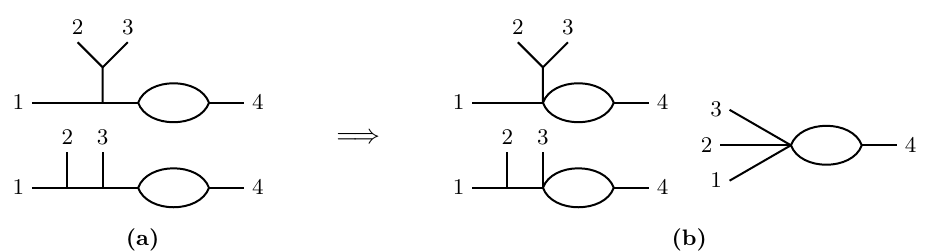
Figure 4. The BCJ numerators associated with the cubic graphs in the left panel (a) conspire to cancel the propagator s − 1 that diverges in the phase space of four on-shell momenta. After 123 cancellation of their divergent propagator, the contributions of external bubbles may be visualized as “snail graphs” drawn in the right panel